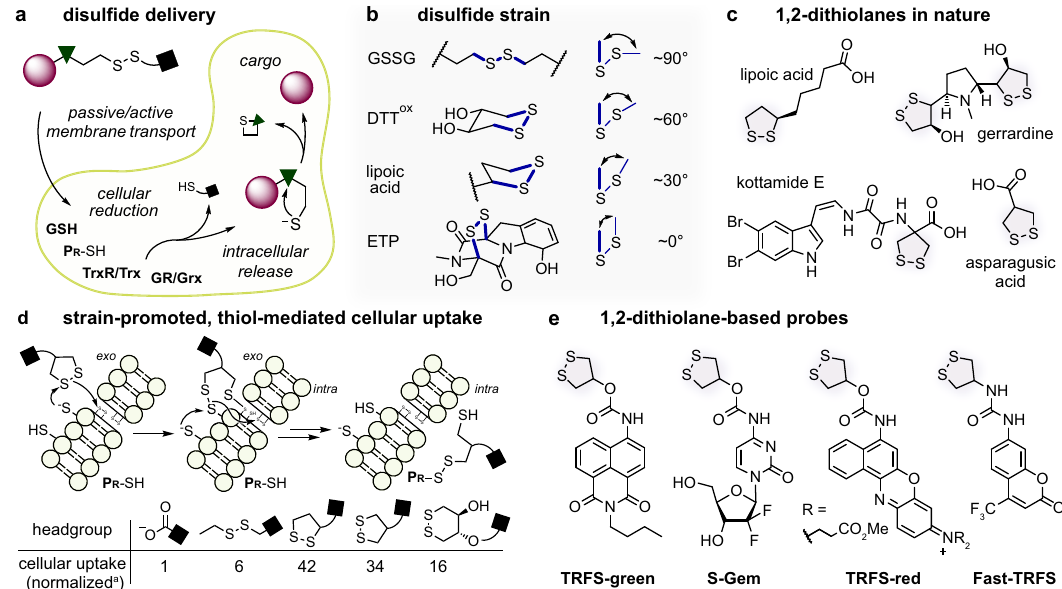
Fig. 1 1,2-dithiolanes in chemical biology. a Linear disul fi de-based cellular delivery: irreversible cleavage of linear disul fi des after cell entry leads to intracellular cargo release ( P R -SH : intracellular protein thiol). b From linear, to cyclic 6-membered, to increasingly ring-strained 5-membered disul fi des, to ETPs. c Strained 1,2-dithiolanes in natural products. d Fast, irreversible and nonspeci fi c thiol-disul fi de interchange of 1,2-dithiolanes by exofacial thiols, followed by dynamic transmembrane exchange cascades, enhances cellular uptake and intracellular delivery. [ a :data from Matile et al. 30 ]. e Some of the Reductase Fluorogenic Substrate “ 16,18,45